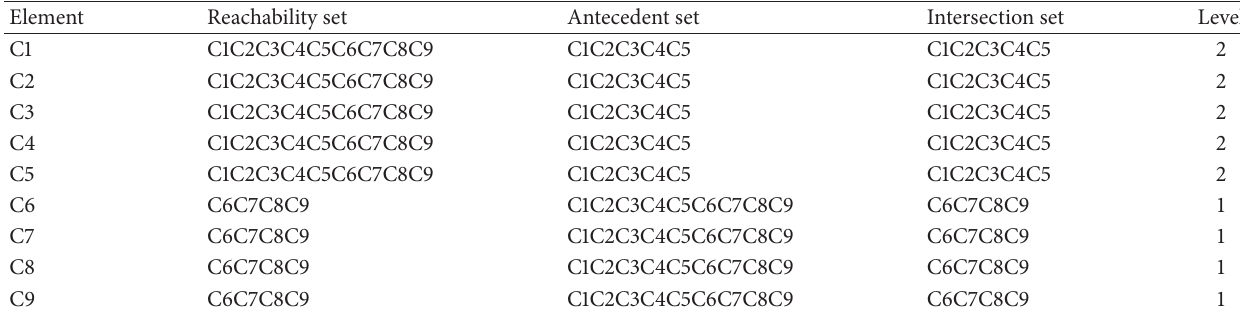
Table 5: Levels of model 3 elements.